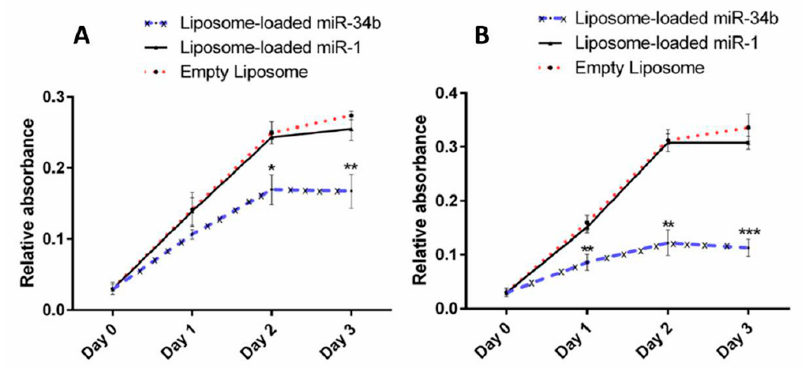
Figure 2. The effect of miR ‐ 34b upregulation on proliferation of thyroid carcinoma cells. Overexpression of miR ‐ 34b significantly inhibited proliferation of cells in 8505C ( A ) and BHT ‐ 101 ( B ). Both anaplastic thyroid carcinoma cell lines treated with liposome ‐ loaded miR ‐ 34b showed notable reduced cell proliferation when compared to liposome ‐ loaded miR ‐ 1 and empty liposome transfected groups on different days after transfection. The results are shown as mean ± SD from three independent tests. Level of significance, * p < 0.05, ** p < 0.01, *** p < 0.001 when compared to the control groups.